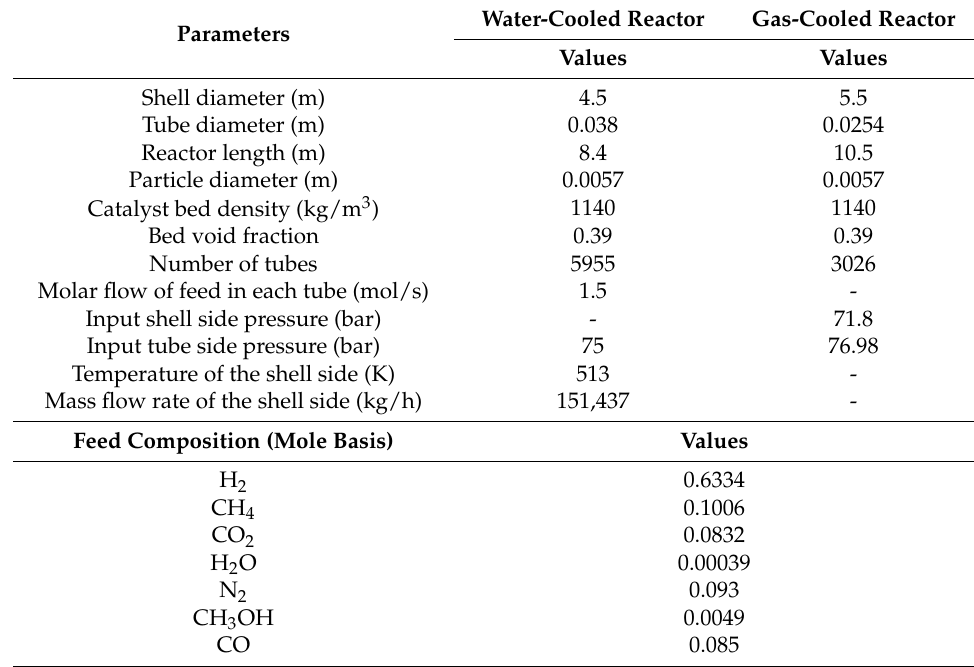
Figure 1. The schematic diagram of ( a ) CR configuration [9]; ( b ) AW configuration; and ( c ) ACW configuration. Table 2. The conditions and specification of reactors and catalyst of conventional methanol synthesis process with two reactors (CR